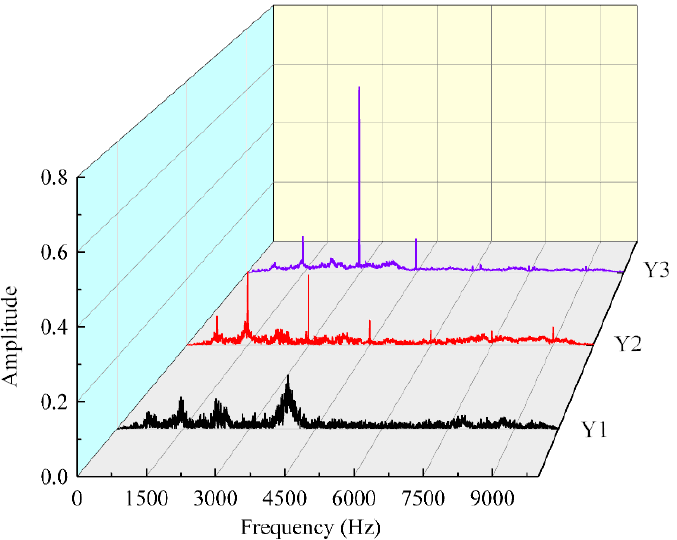
Figure 6. Frequency characteristics of independent components. The maximum amplitude of the independent component Y2 appears at the rotation fundamental frequency and, with the increase in frequency, the signal peak of the charac- teristic frequency gradually decreases. Therefore, Y2 is the “buzz-saw” noise caused by the periodic rotation of the impeller, including the aerodynamic noise and mechanical noise. The independent component Y1 is concentrated in the low-frequency band, especially the narrow-band noise near 3866 Hz, without obvious periodic characteristics. Therefore, the independent component Y1 signal is the wide-band noise caused by the secondary flow and flow separation process of gas in the blade tip clearance [11]. Based on the noise characteristics of the high-speed centrifugal air compressor of the vehicle fuel cell, the noise signal of the rotating fundamental frequency is mainly composed of the fundamental frequency signal of the “buzz-saw” noise. The second harmonic frequency is composed of the motor noise and the “buzz-saw” noise, forming the maximum amplitude of the noise. The sound pressure levels of the discrete single-tone noise and the wide-band noise are